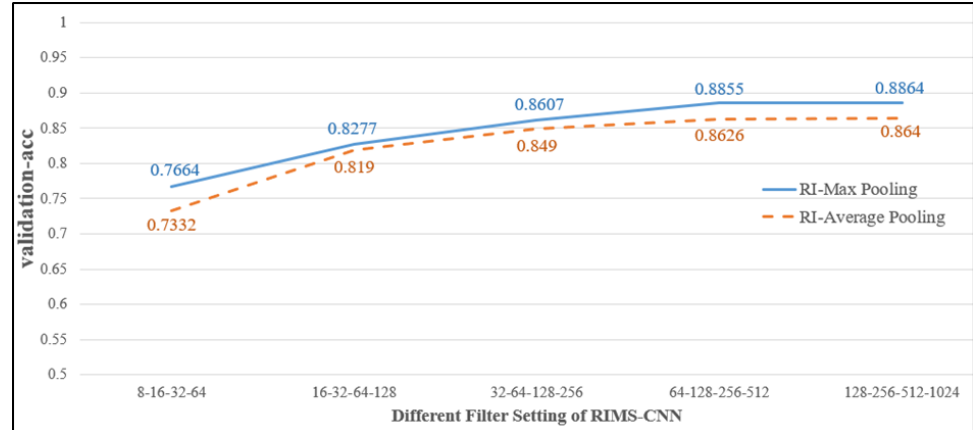
Figure 18. Comparing RI-max pooling with RI-average pooling on the fixed-angle rotated CIFAR- 10.